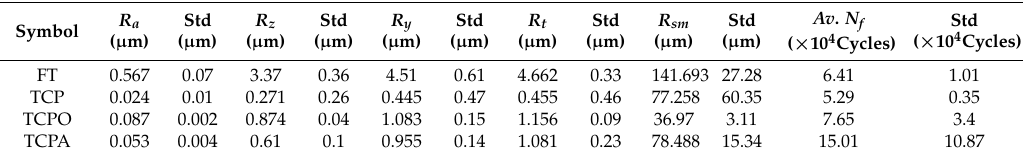
Table 2. The average value of surface roughness and fatigue life at different processes. Av . N f : average fatigue life. Std: standard